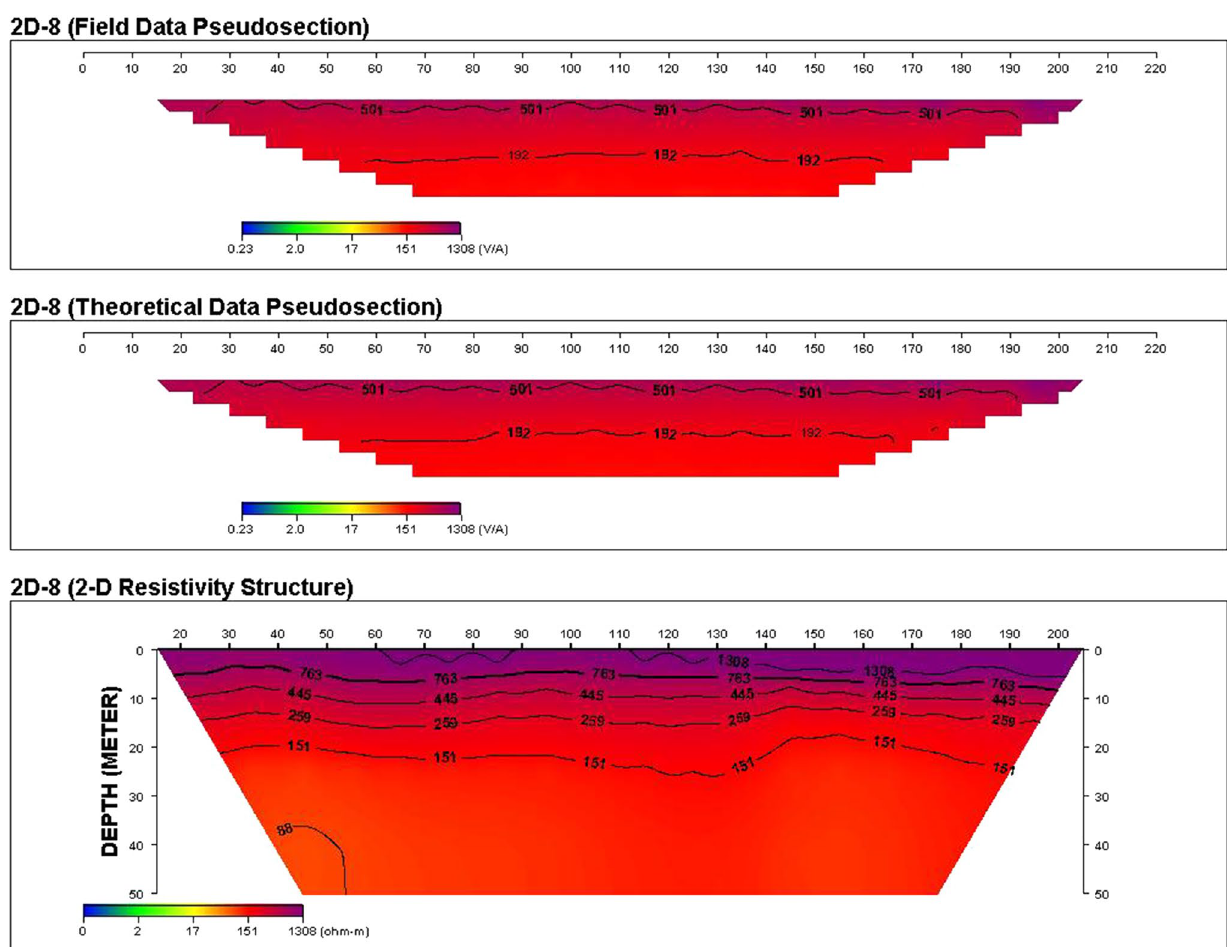
Fig. 3 Representative samples of the inverted data showing the field and theoretical data pseudosections and the inverted 2D resistivity